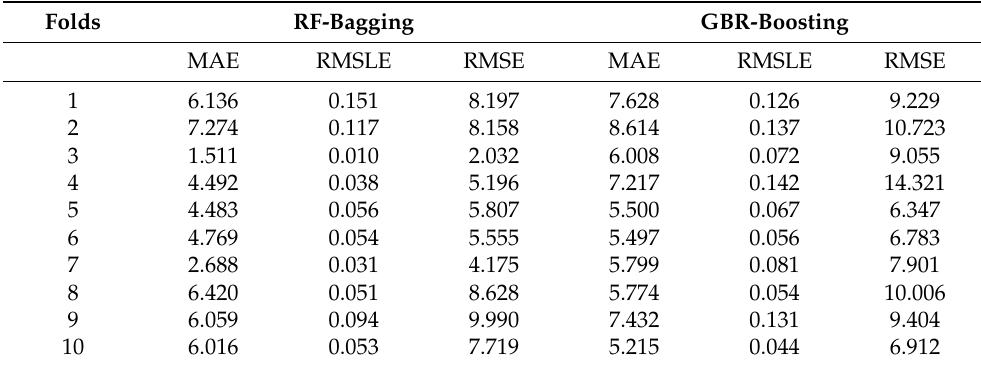
Table 12. K-Fold cross-validation result of ensemble models. Folds